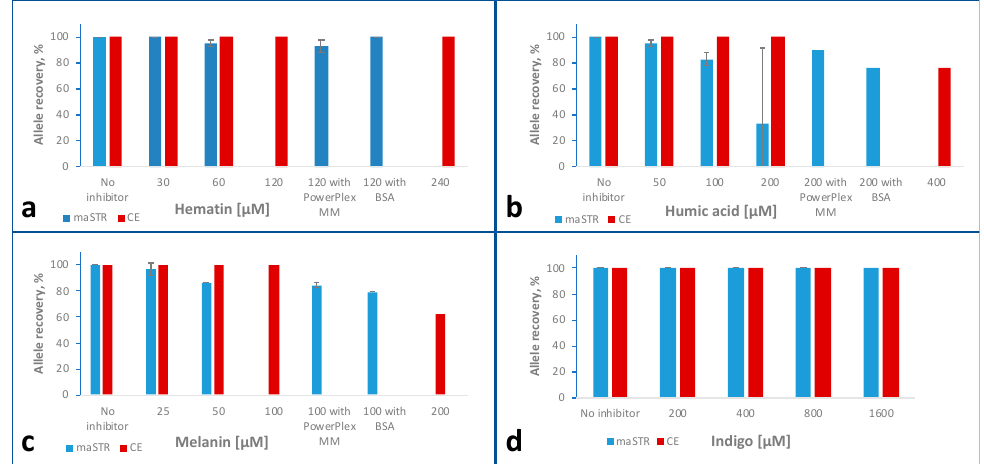
Figure 4. Inhibitor study comparing allele recoveries obtained with the maSTR assay (blue bars) or with CE using PowerPlex ESX17 kit (red bars). Human DNA was mixed with inhibitors of the concentrations indicated. For two samples, the PCR buffer of the maSTR assay was replaced by the reaction buffer of the PowerPlex ESX17 kit (PowerPlex MM) or supplemented with 0.6 µM BSA, respectively. Error bars represent standard deviations. ( a ) Results with hematin. Please note that with maSTR assay at 120 µM hematin, no alleles were called. ( b ) Results with humic acid. ( c ) Results with melanin. Please note that with maSTR assay at 100 µM melanin, no alleles were called. ( d ) Results with indigo.